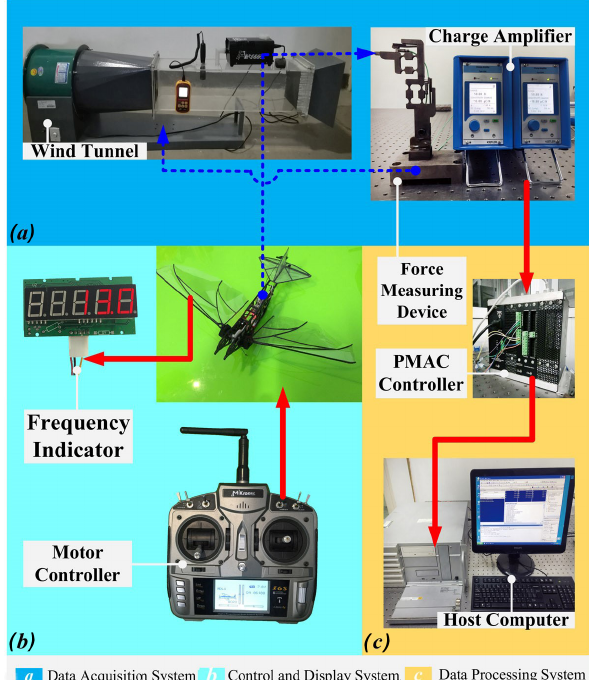
Figure 8. Procedure chart of the flapping test. (a) The data acquisi- tion system consists of a wind tunnel, a force measuring device, and the charge amplifiers. (b) The control and display system consists of a motor controller and the frequency indicator. (c) The data pro- cessing system consists of a PMAC controller and a host